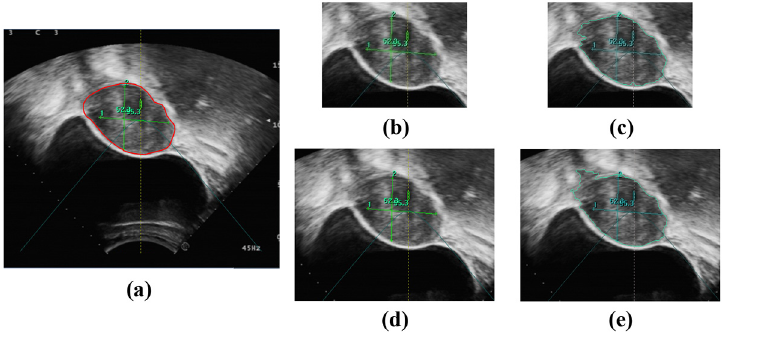
Fig 16. An example of tumor segmentation with great heterogeneous structure in different ROIs. (a) The original image. (b) The first ROI image. (c) Segmentation result of (b). (d) The second ROI image. (e) Segmentation result of